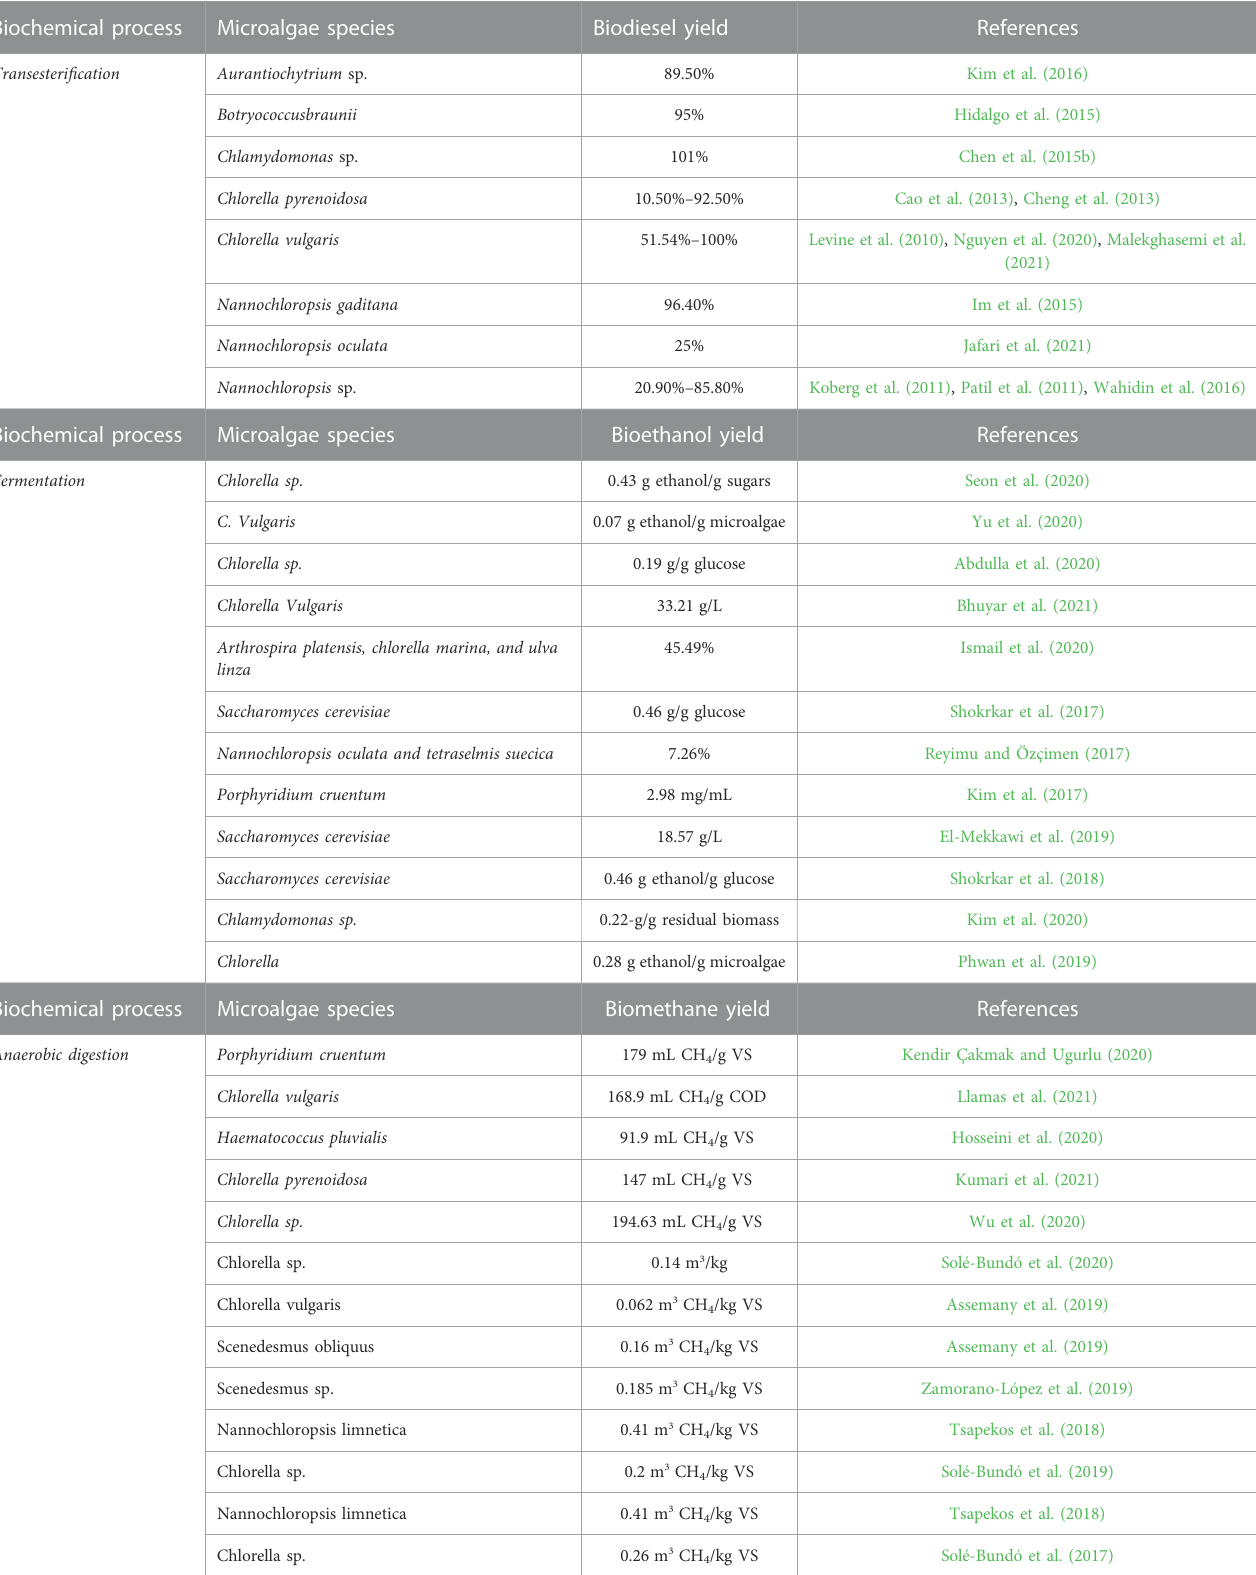
TABLE 1 Summary of the fi ndings of studies conducted on the production of biofuel from microalgae using various biochemical processes. Biochemical